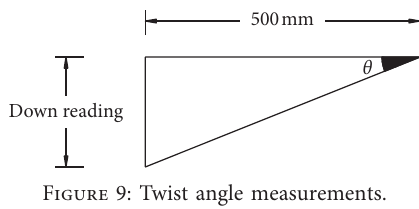
Figure 9: Twist angle